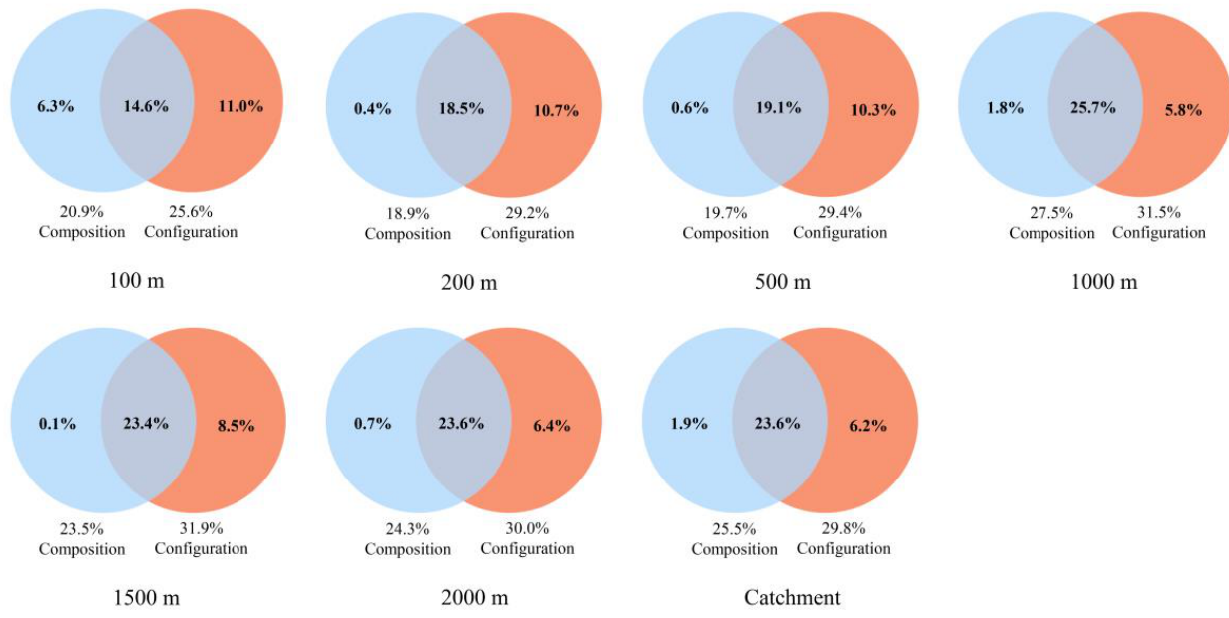
Figure 6. Fractions of the variation explained by individual and joint effects of the land use composition and configuration.